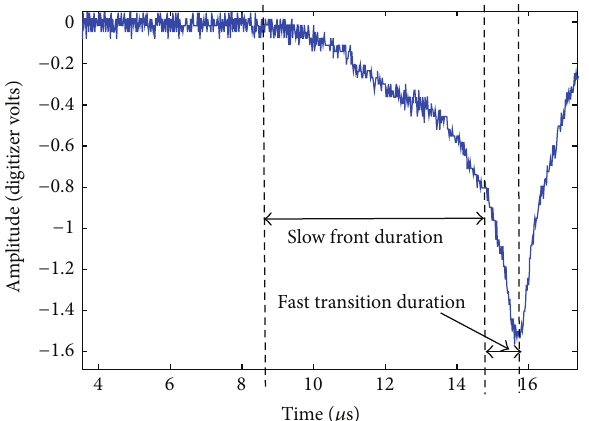
Figure 2: Slow front and fast transition sequence in a positive return stroke electric field waveform recorded on November 27, 2012, 3:14:24 pm at UTM observatory.